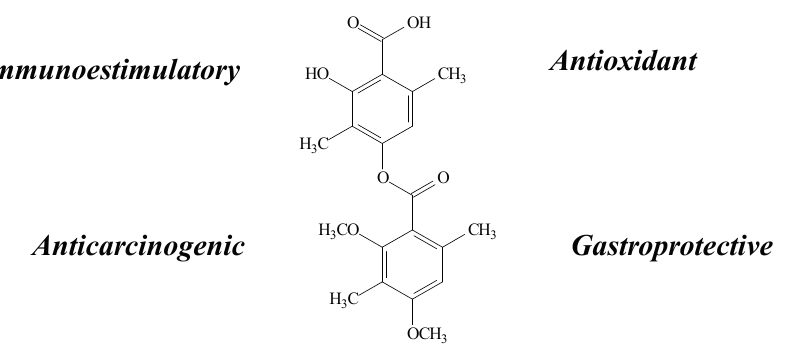
Figure 5. Diffractaic acid structure and biological